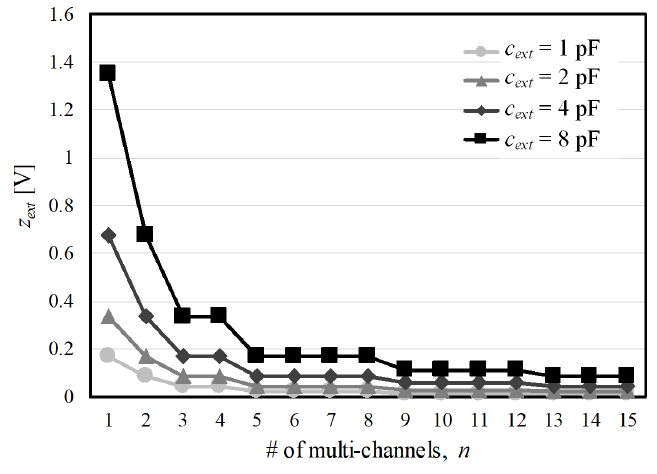
Figure 8. Reduction in the external noise with respect to the number of TX channels and for different gain sets in f c = 380 kHz, e ext ( f ) = δ ( f − 200k )